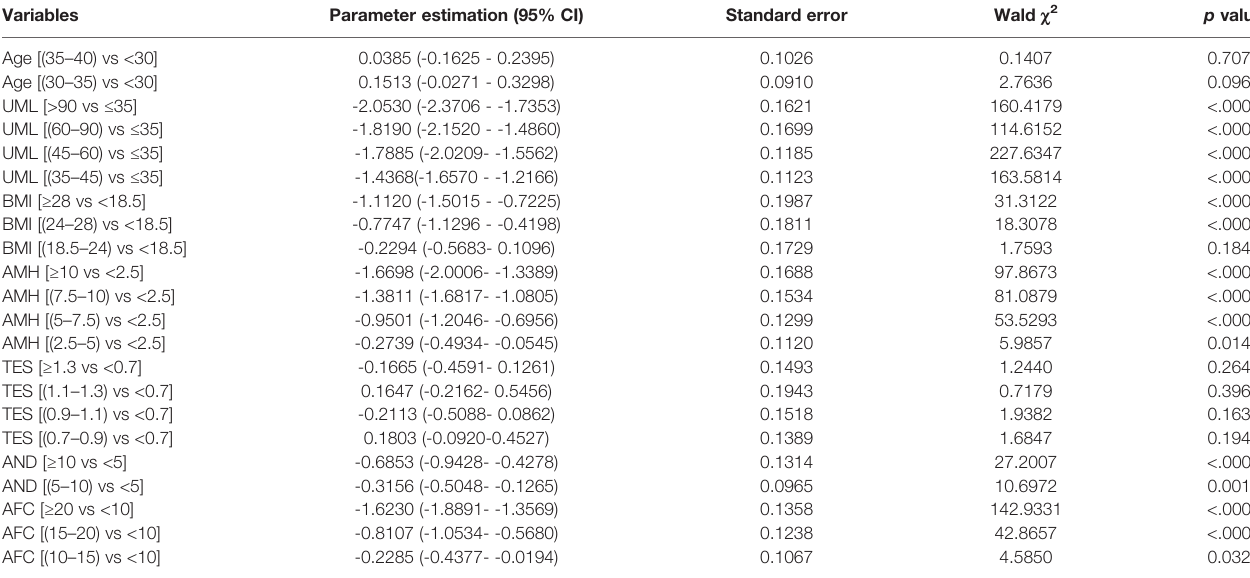
TABLE 2 | Multiple analysis of the effects of each predictive variable on PCOS in Model 1 with AFC. Variables Parameter estimation (95%